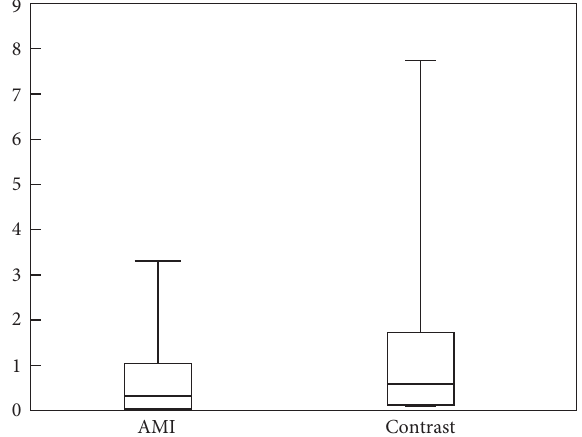
Figure 1: Relative expression of the FFAR2 gene. AMI � acute myocardial infarction.